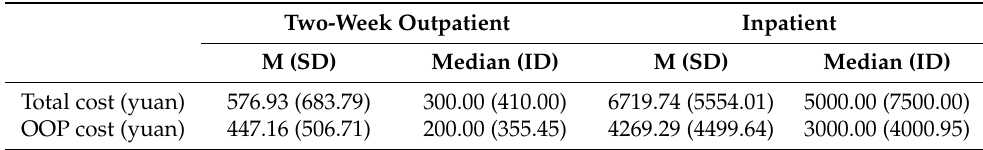
Table 2. Total cost and OOP cost of health service utilization.